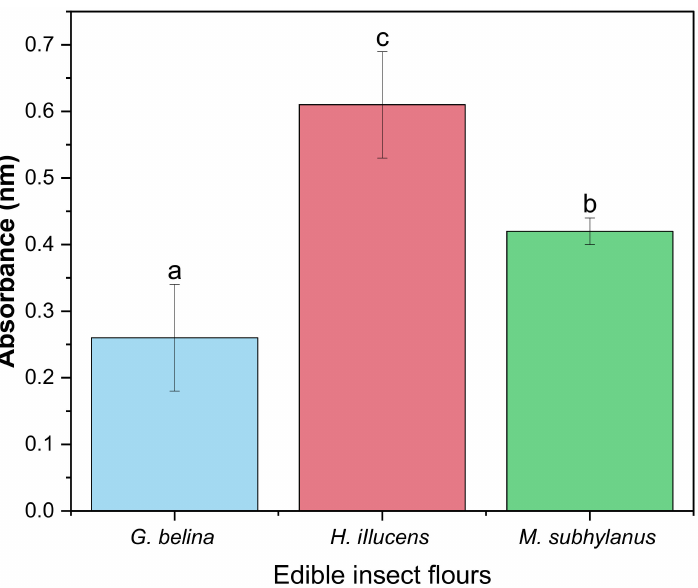
Figure 4. Reducing power activity of edible insect flours. Values are mean ± standard deviation; means with different superscripts are significantly different ( p <